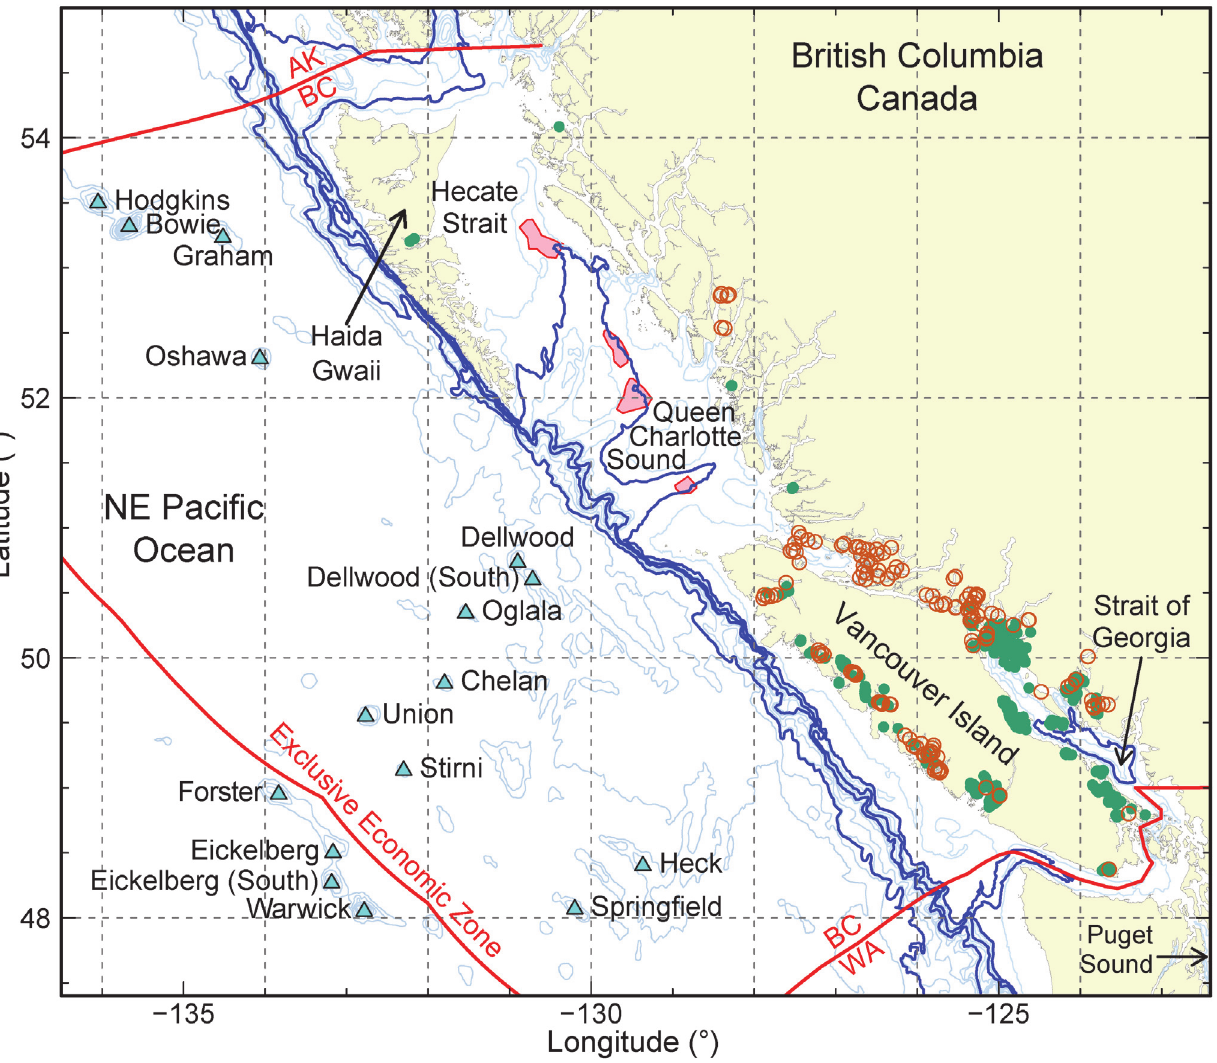
Fig 1. British Columbia (BC) coastline and bathymetry (isobaths in metres: thin grey — 100, 200, 300, ... , 1000, 1250, 1500, 2000, 2500; thick blue — 200, 500, 800, and 1600). The continental slope along most of BC comprises steep slopes, especially along the west coasts of Haida Gwaii and northern Vancouver Island. Hecate Strait is largely dominated by shallow waters and a flat seafloor. Sponge reef core protected areas in Hecate Strait and Queen Charlotte Sound are shaded pink. The Strait of Georgia forms a large inland sea that is heavily influenced by river runoff and tidal currents. Saltwater finfish farm and hatchery sites are indicated by open red circles, commercial marine shellfish farms are indicated by solid green circles [345]. Select seamounts [346] are marked by blue triangles. Canada ’ s Exclusive Economic Zone (200-nautical miles offshore) is delimited in red. Map was prepared using PBSmapping in R [347]. The R code is provided as Supporting Information (S1 Code).